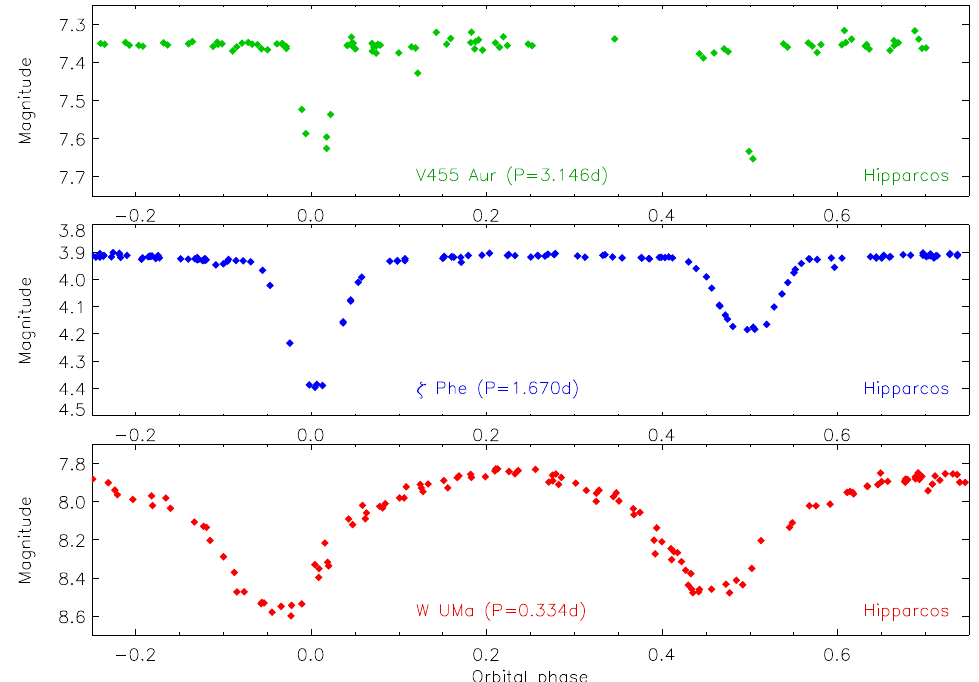
Figure 3. The Hipparcos satellite light curves of three example EBs. V455Aur ( top ) was chosen as it was these data that enabled its discovery. ζ Phe ( middle ) was selected for comparison with the TESS data in Figure 1. WUMa ( bottom ) was picked as it is the prototype eclipsing contact binary; the TESS data of this object are shown in Figure 9 for